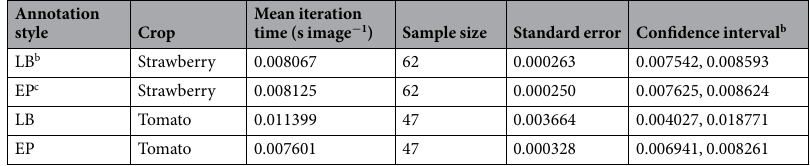
Table 3. Impact of annotation style on testing iteration time for goosegrass ( Eleusine indica ) detection in strawberry ( Fragaria × ananassa ) and tomato ( Solanum lycopersicum ) production using a convolutional neural network developed at Balm, FL, USA in 2018 a . a The neural network was the tiny version of the state-of-the-art object detection convolutional neural network You Only Look Once Version 3 (Redmon and Farhadi 2018). b LB = Leaf-blade annotation method. This refers to using multiple, small square boxes placed along leaf blades and inflorescence to identify goosegrass within digital images. c Entire plant refers to the annotation method where a single, large square box to was used to identify goosegrass within digital images.